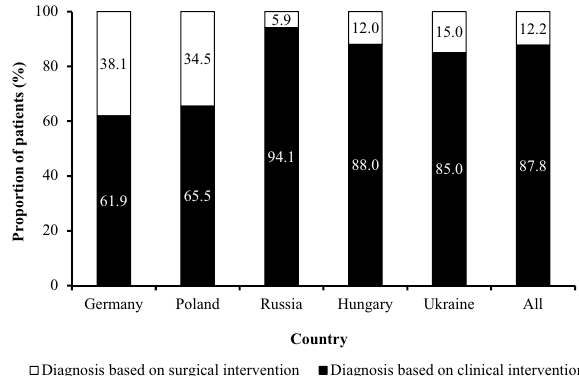
Figure 1. Diagnosis based on clinical symptoms and surgical intervention by country. Patients from Switzerland are not presented here as a subcategory owing to low patient numbers ( n = 74).